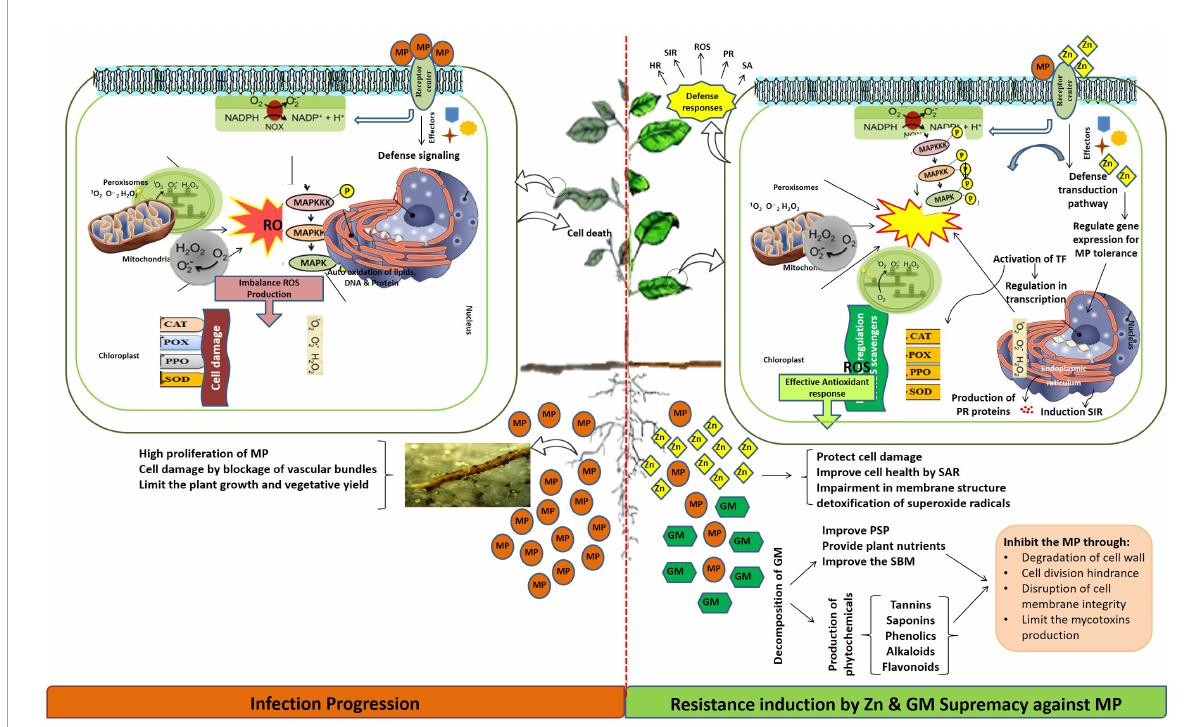
FIGURE5 Possible effect of Macrophomina phaseolina (MP), zinc (Zn), and green manure (GM) in mungbean